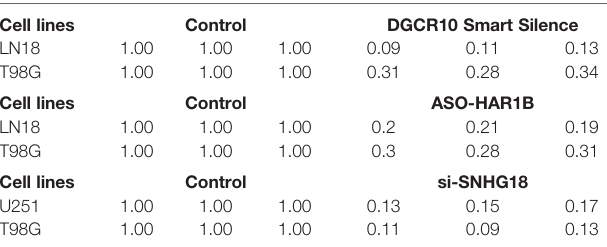
TABLE 3 | The relative expression level of DGCR10, HAR1B and SNHG18 in different glioma cell lines after knockdown. Cell